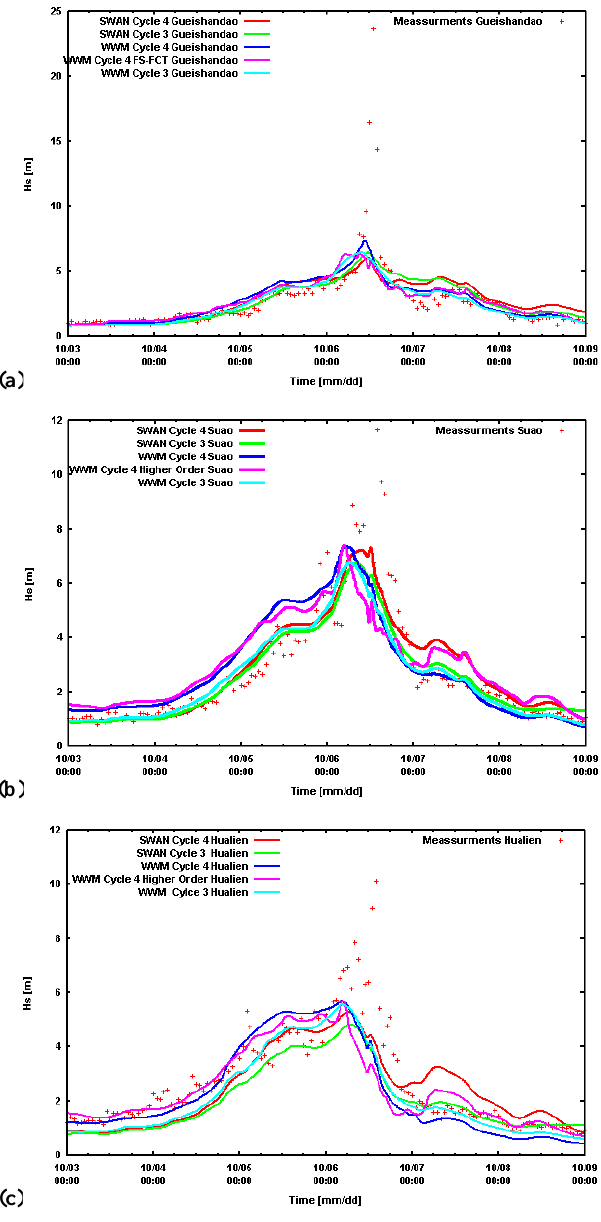
Fig. 7. Simulation results and measurements for the three buoy locations. (a) Guishandao Island; (b) Suao Buoy; and (c) Hualien.